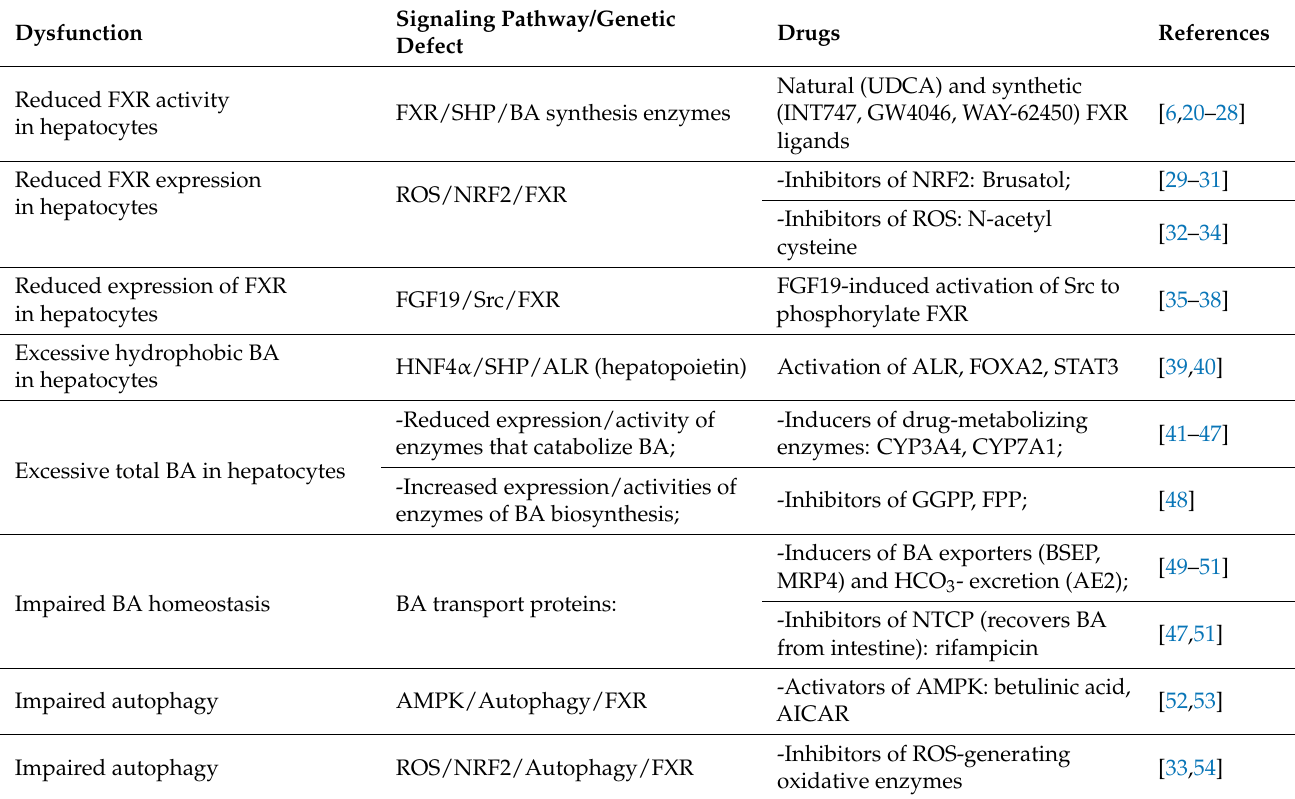
Table 1 summarizes the newest targets for drugs against cholestasis based on mecha- nistic studies on FXR and its role in BA homeostasis. Table 1. New drug targets related to BA homeostasis and FXR for treating cholestasis-induced hepatic fibrosis.